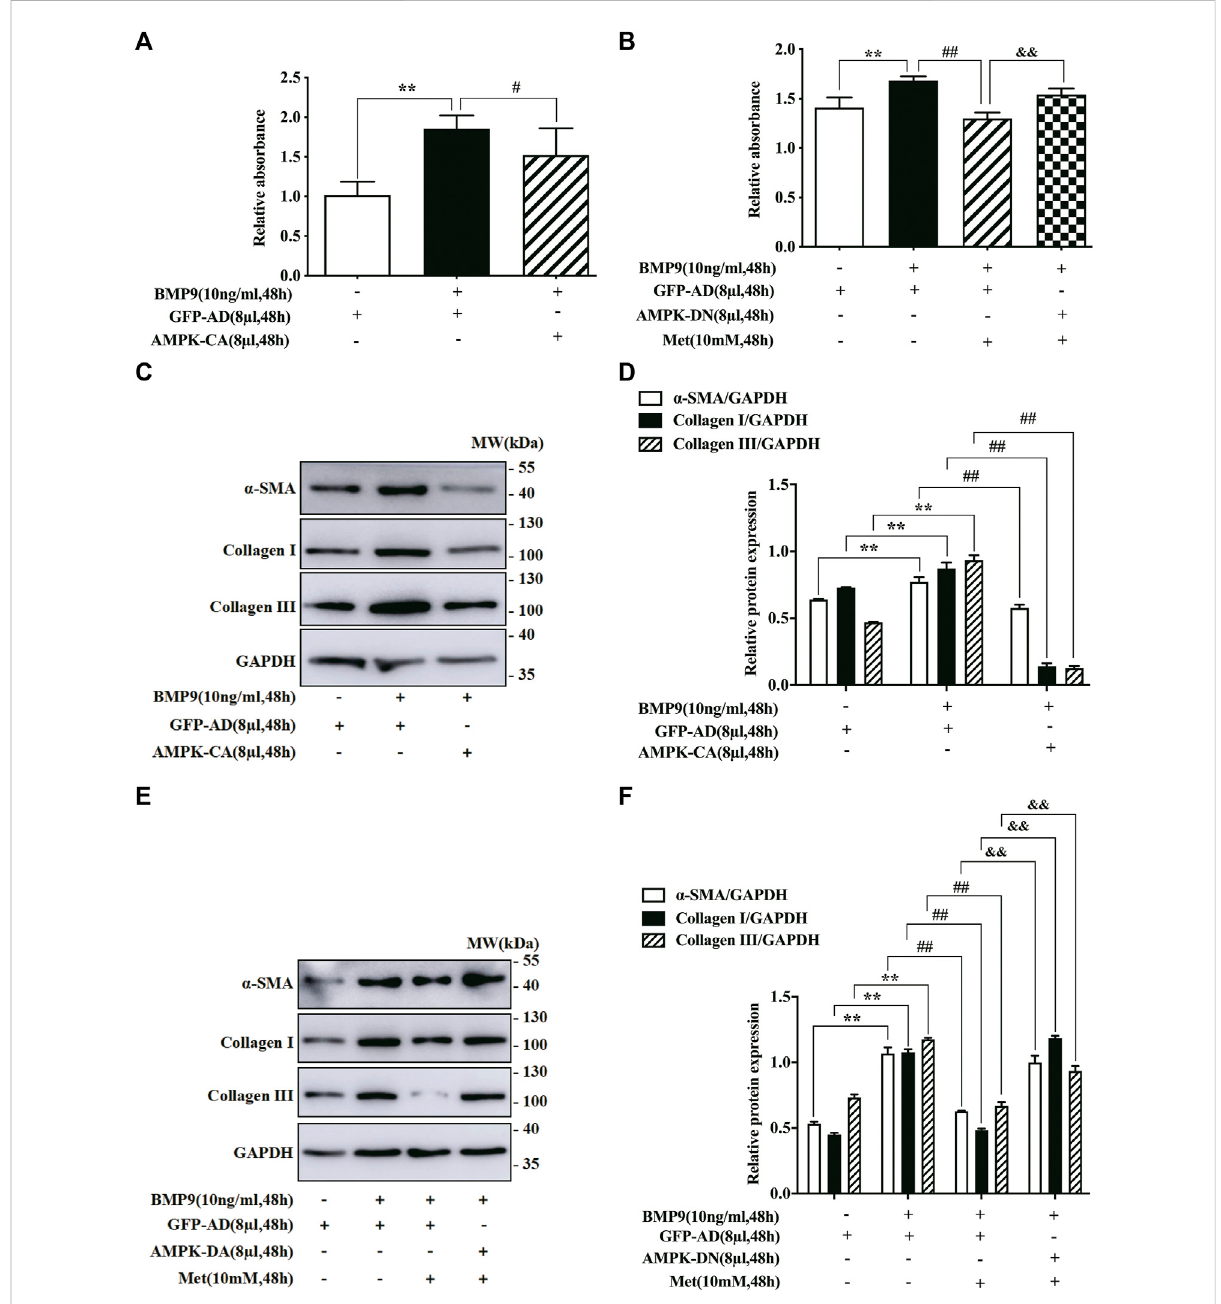
FIGURE 3 Effect of AMPK mutants on BMP9-induced proliferation and differentiation of HFL-1 cells. (A) CCK-8 assay was used to detect the effect of AMPK-CA on the proliferation of HFL-1 cells induced by BMP9 ( n = 3). (B) CCK-8 assay was used to examine the role of AMPK-DN in the inhibitory effect of metformin on BMP9-induced proliferation of HFL-1 cells ( n = 3). (C,D) : The roles of AMPK-CA in the protein expression of fi broblast differentiation markers ( ɑ -SMA,Collagen Iand Collagen III) weredetected bywestern blot( n =3). (E,F) :Theeffects ofAMPK-DNon theprotein expressionof ɑ -SMA,CollagenIandCollagenIIIweretestedbywesternblot( n =3).Dataarepresentedasmean±SD.** p < 0.01versusonlyGFP-AD group, # p < 0.05 and ## p < 0.01 versus GFP-AD with BMP9 group, && p < 0.01 versus GFP-AD with BMP9 and metformin